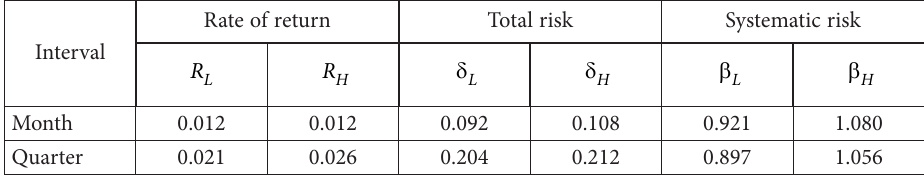
Table 12. Empirical results (the number of stocks is 124; the weight constraint is 0.05) Rate of Interval